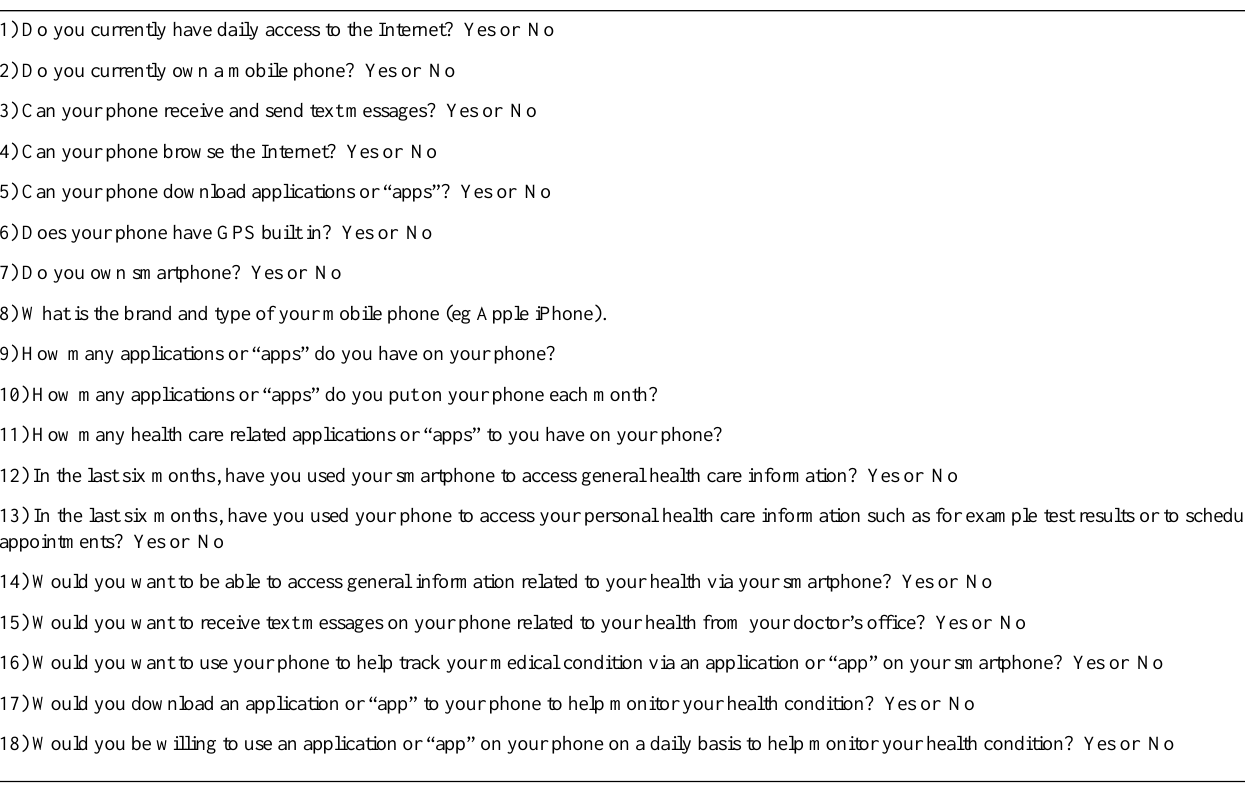
Textbox 1. Questions from the paper survey used for the